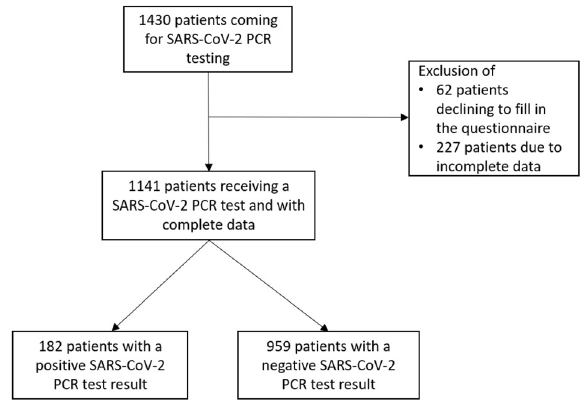
Fig. 1 Flow chart of the patients. Consecutive recruitment of patients in 19 general practices, depicted by exclusion criteria and PCR test